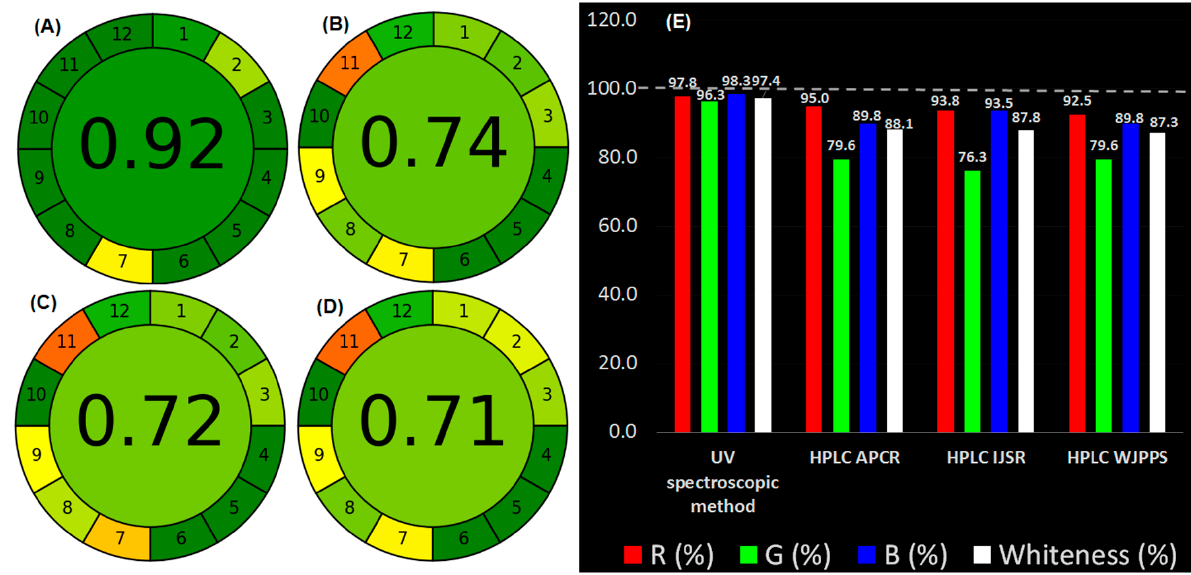
Figure 6. AGREE score for UV spectrophotometric method ( A ) and HPLC methods ( B – D ). Compar- ison of whiteness score between UV spectrophotometric method and HPLC methods ( E )—HPLC IJSR [32], HPLC WJPPS [33], and HPLC APCR [34].